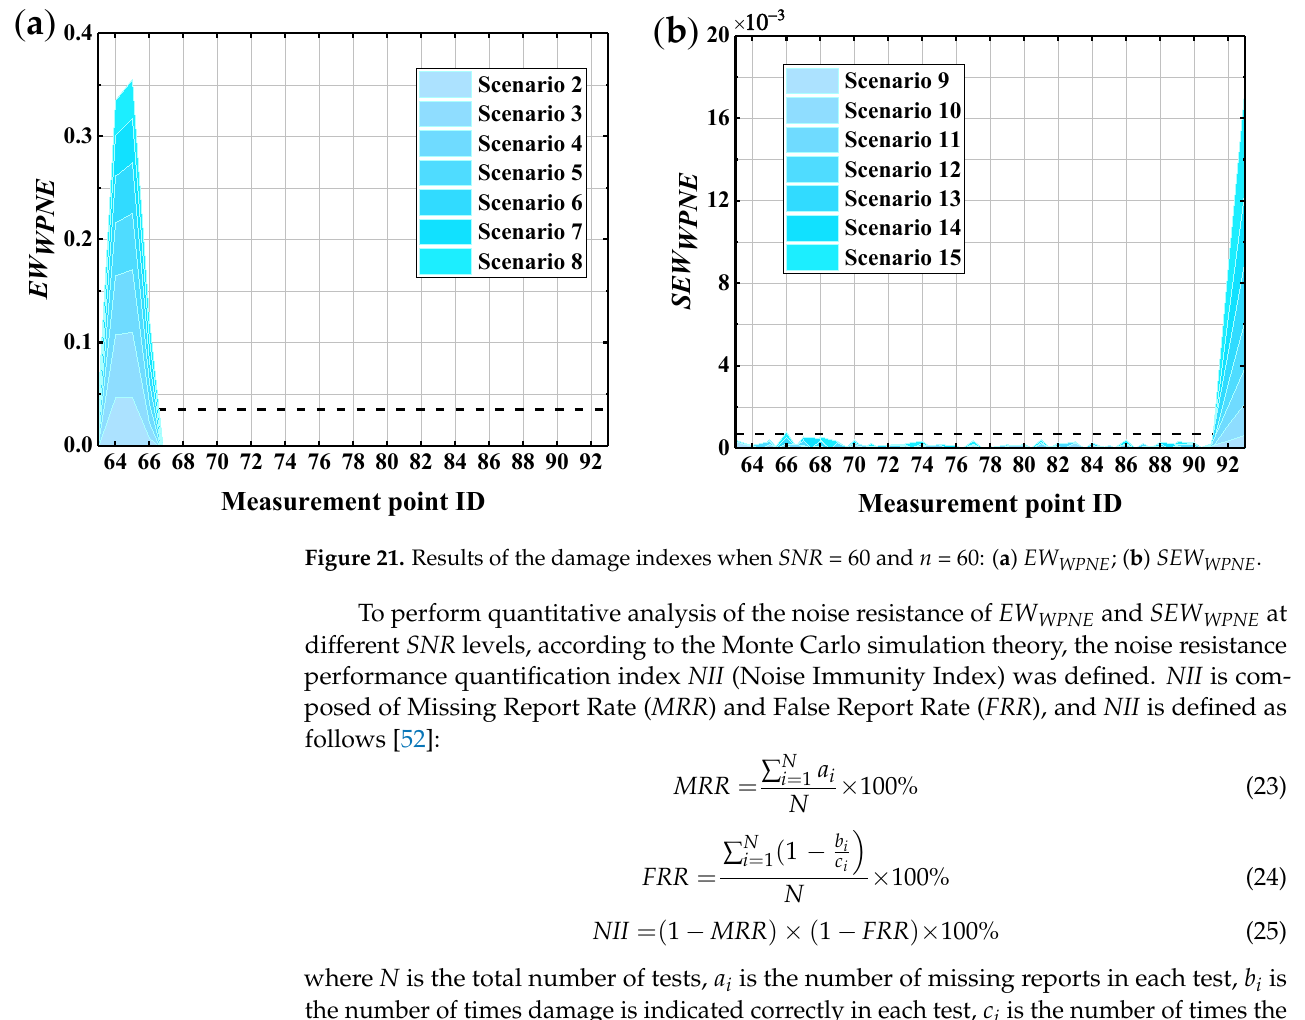
and SEW WPNE WPNE